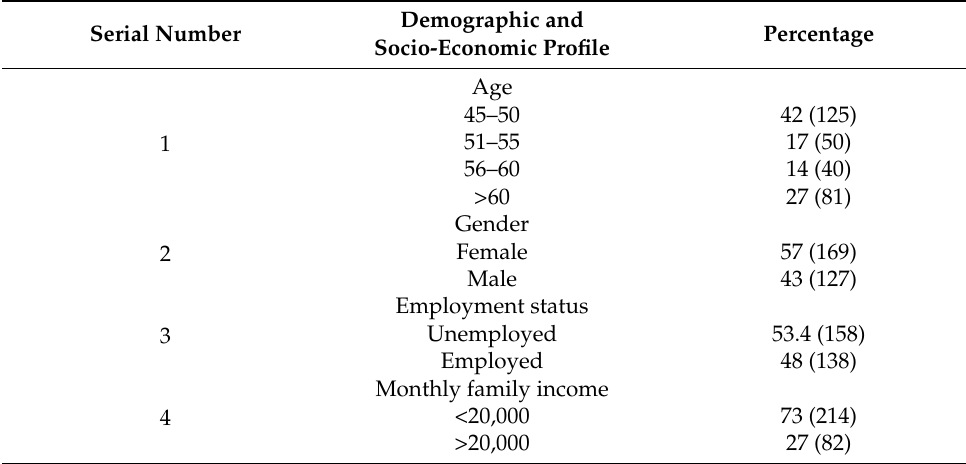
Table 5. Socio-demographic profile of the survey study participants.